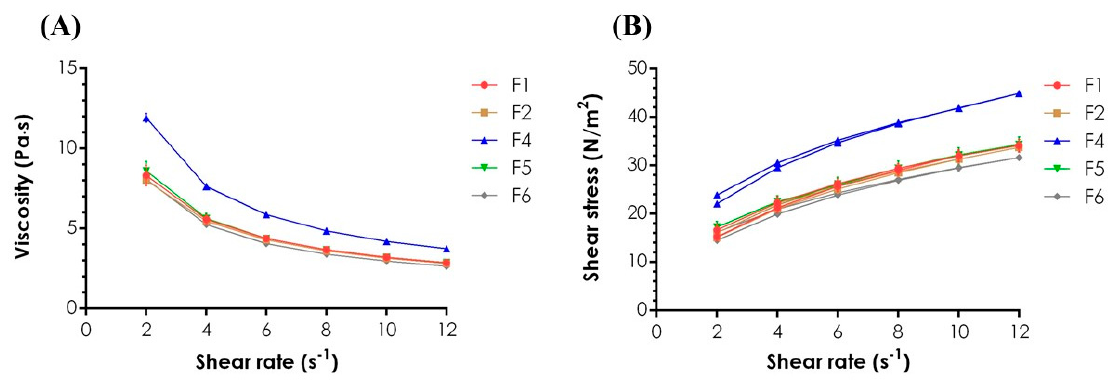
Figure 3. Plots of viscosity vs. shear rate ( A ) and rheograms ( B ) for the hydrogels diluted with simulated saliva (SS) at the weight ratio of 1:1 determined at 37 °C ± 0.5 °C (mean ± SD, n = 3). Table 2. pH and mechanical properties of the hydrogels (mean ± SD, n = 3).